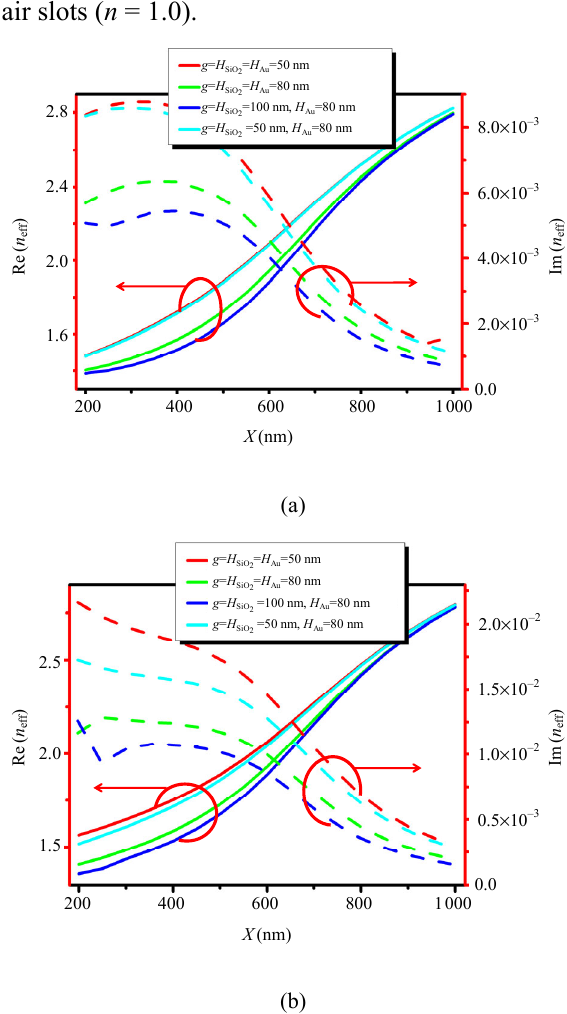
Fig. 3 Real and imaginary parts of the effective refractive index of HPWG: (a) TE hybrid mode and (b) TM hybrid mode.